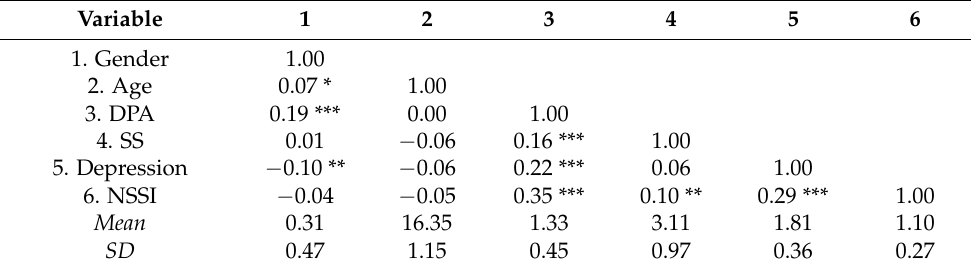
Table 1. Descriptive statistics and ceorrelations for all variables.